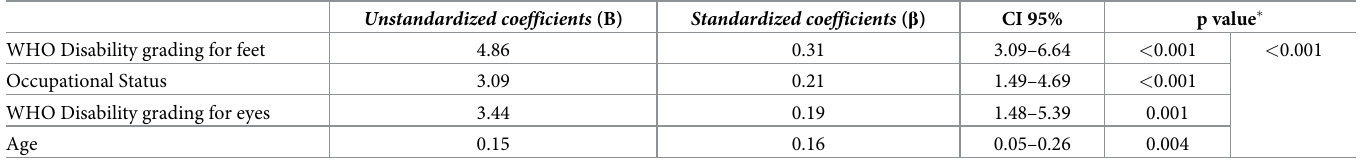
Table 3. Multivariate Analysis of Factors Affecting Total Score SALSA.